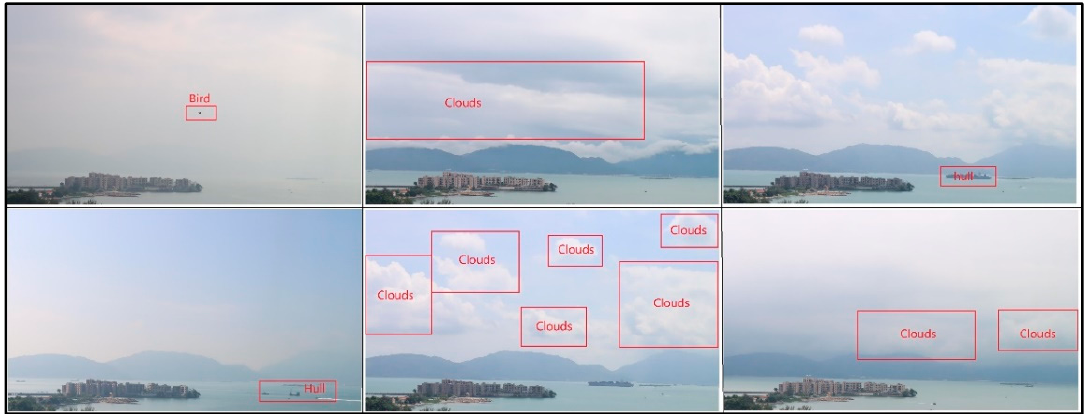
Figure 5. Image samples with interference from moving objects.